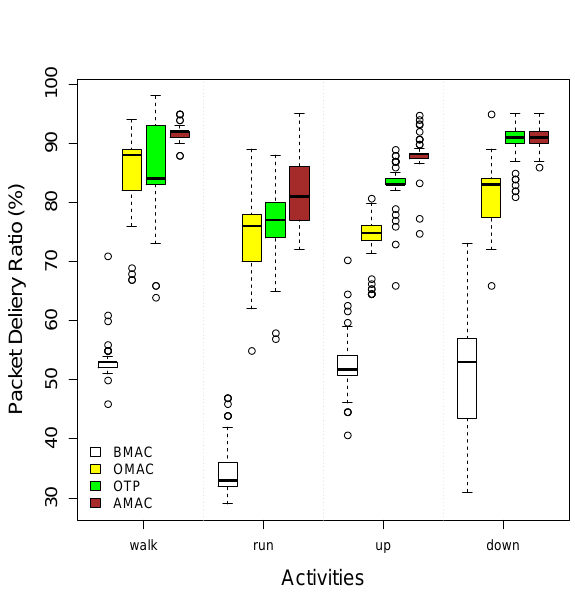
required to evaluate A-MAC under normal clinical condi-